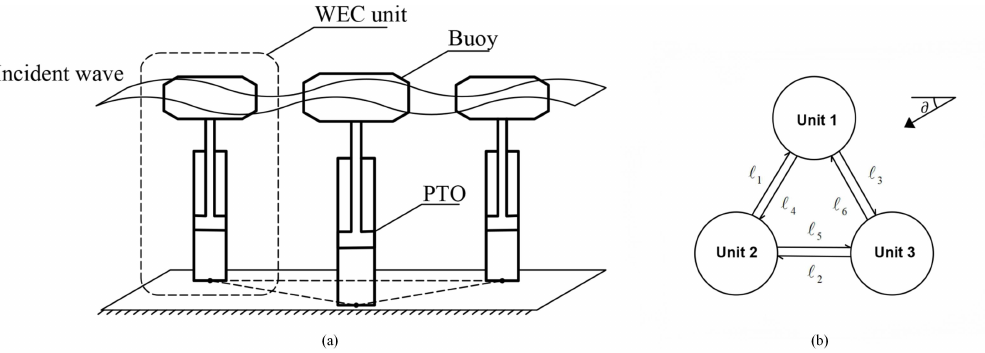
Figure 1. Point absorption WEC array: ( a ) the structure of the point-absorber-type WEC; ( b ) the interfering relationship between three